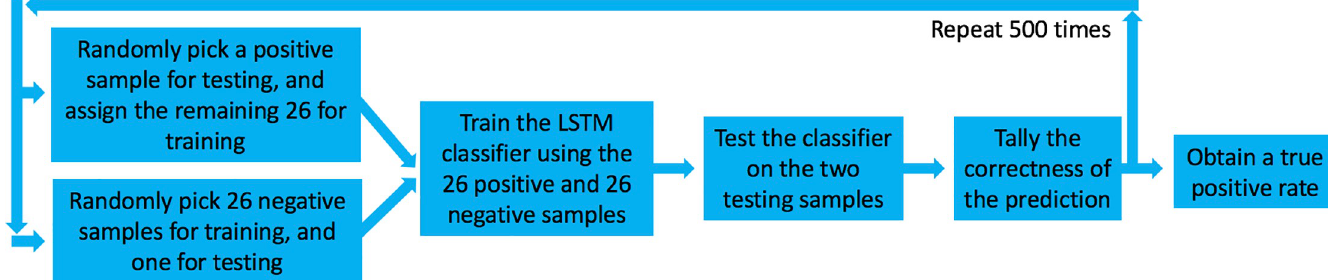
Fig 3. Analysis path. We randomly selected 26 out of 27 positive samples, trained the classifier on these 26 positive samples, and then tested whether it can select between the one remaining positive sample versus one randomly selected negative sample. Chance performance at this task is 50%. We repeated this process 500 times, each time testing a different sample, in order to obtain a true-positive rate. Finally, because no selection of 500 is privileged, we repeated this entire process 100 times in order to obtain a distribution of possible true-positive rates.